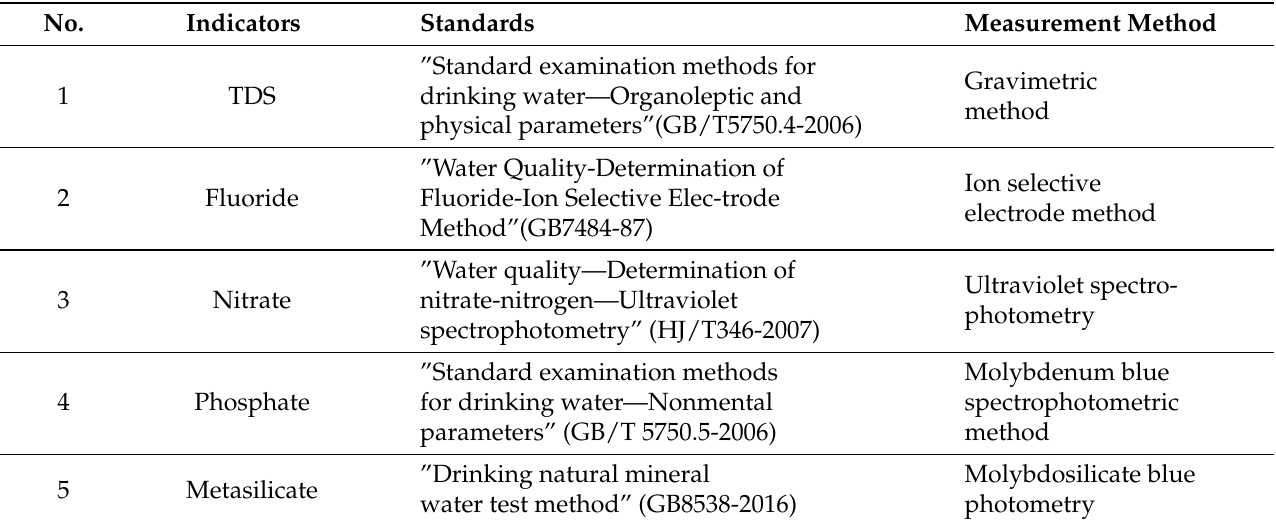
Table 1. Ion concentration detection methods and